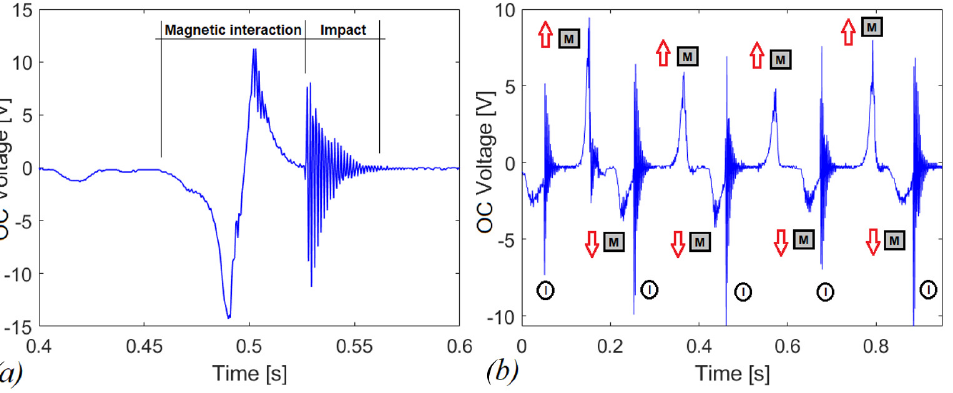
Figure 10. Open-circuit voltage for repulsive interaction combined with impacts ( a ) single snap ( b ) shaking with multiple snaps with indication of motion of mass (M) and impact phases.